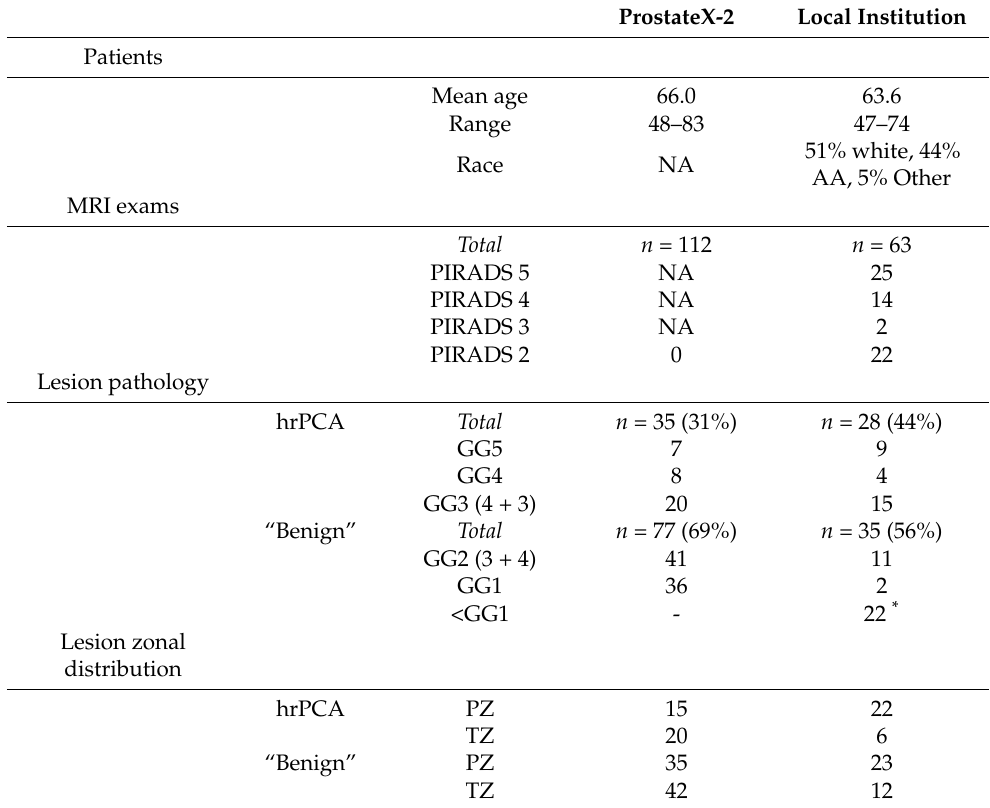
Table 1. Summary of patient demographics, MRI PIRADS scores, lesion Gleason grades, and lesion zonal distribution within the ProstateX-2 and local institutional datasets. ProstateX-2 Local Institution Patients Mean age 66.0 63.6 Range